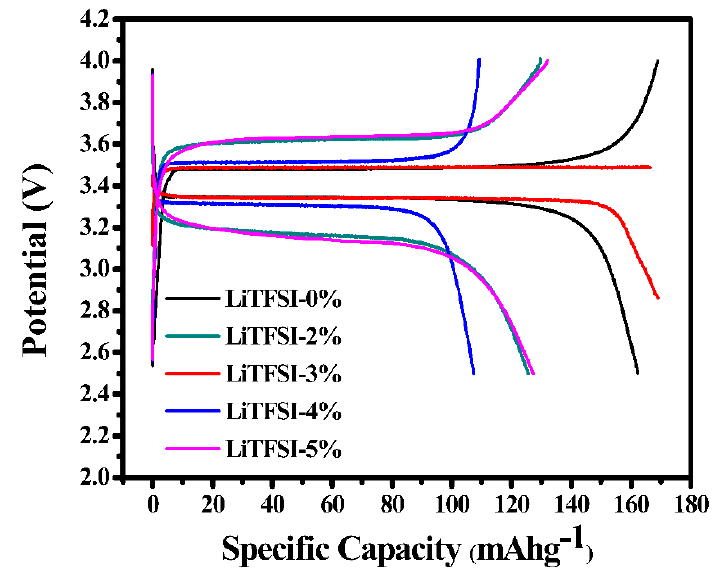
Figure 5. Typical charge–discharge curves of Li|LATP/PVDF-HFP|X% LiTFSI (X = 0, 2, 3, 4, 5) +LiFePO 4 cells at 0.1 C.